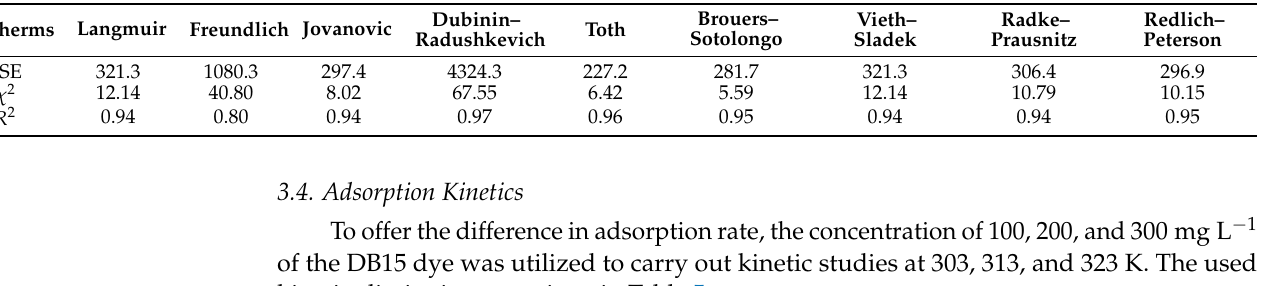
Table 5. Parameters used for adsorption kinetic models in the present research.